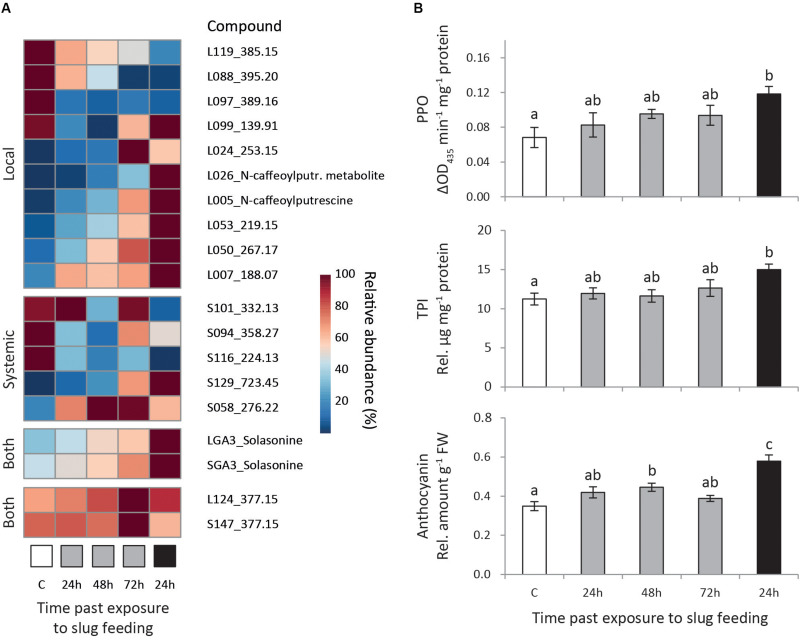
Induced responses in Solanum dulcamara leaves after feeding by the gray field slug (GFS, Deroceras reticulatum). Plants (n = 6) were left undamaged (control treatment: C, white) or exposed to feeding by GFS for 24 h (gray) or 72 h (black). Samples were collected 24, 48, or 72 h after the end of the treatment period (see also Figure 1). (A) Mean relative abundance of metabolites of interest, the levels of which were affected by GFS feeding in at least two treatments or in both local and systemic leaves within one treatment. The metabolite ID for local (L) and systemic (S) leaves is composed of a unique number and the quantified mass (m/z). (B) Mean relative levels (±SE) of polyphenol oxidase (PPO) activity, trypsin protease inhibitor (TPI) activity and total anthocyanins in local leaves. Treatment effects were significant according to one-way ANOVA (Table 2). Different letters over the bars indicate significant differences among treatments according to Tukey post hoc test (P < 0.05).